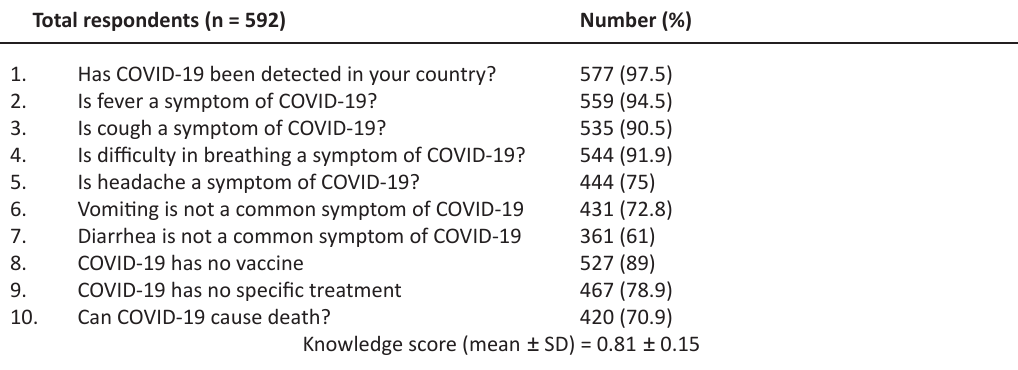
Fig. 1. Reported source of knowledge about COVID-19 SM: Social media, WHO: World Health Organisation, MOH: Ministry of Table 2. Prevalence of knowledge among the participants (those who answered correctly by choosing ‘’yes’’)